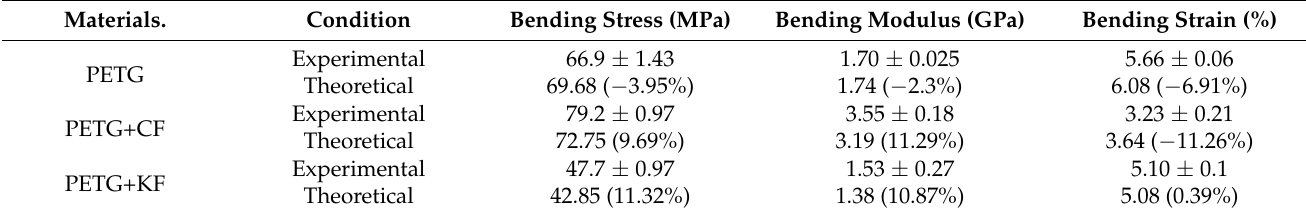
Table 12. Comparison between experimental and theoretical